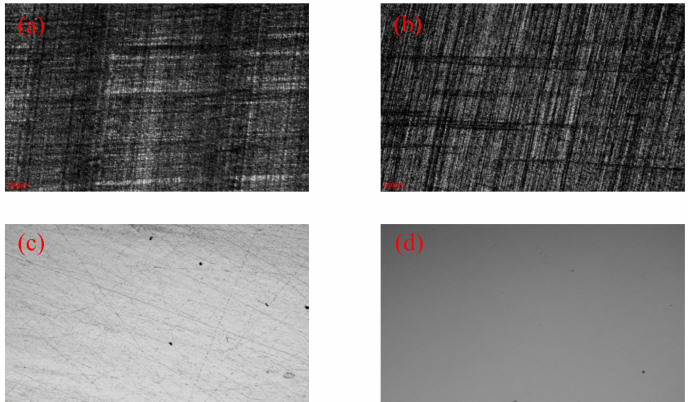
Figure 1. Surface of the samples after different processing methods. ( a ) Sample 1 with the surface after wire cutting. ( b ) Sample 2 with the surface after polishing. ( c ) Sample 3 with the surface after mechanical polishing. ( d ) Sample 4 with the surface after chemical mechanical